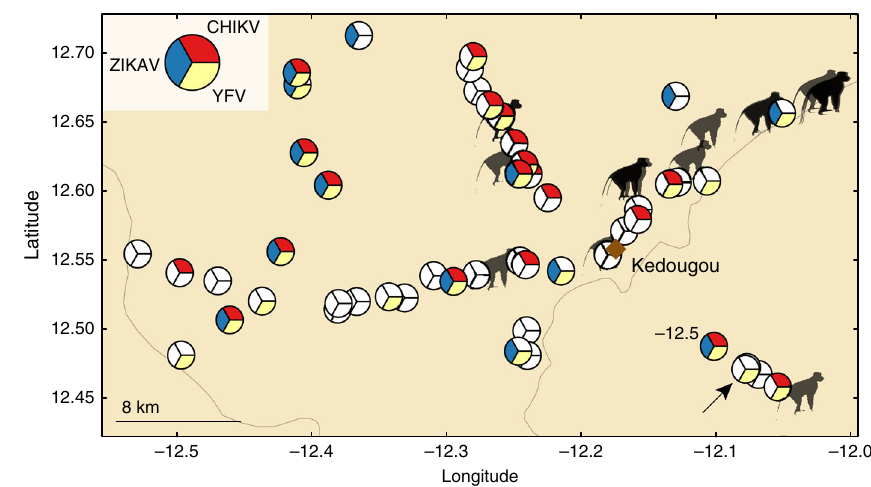
Fig. 2 Distribution of monkey collection sites relative to chikungunya, yellow fever, and zika virus isolations from mosquitoes, 2009 – 2011. Figure shows the spatial distribution of monkey collection sites (monkey symbols) and the mosquito collection sites (pie charts). Pie slices indicate mosquito collection moving clockwise from 2009 at the top. Red indicates chikungunya virus (CHIKV) mosquito isolates in 2009, yellow indicates yellow fever virus (YFV) mosquito isolates in 2010, and blue indicates Zika virus (ZIKV) mosquito isolates in 2011; un fi lled (white) slices indicate that there was no virus isolation in that year. Diamond indicates Kédougou town. Arrow indicates a ZIKV mosquito isolate that is